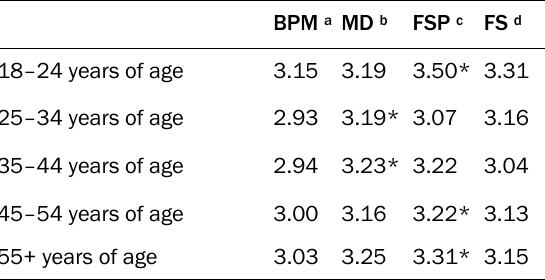
Table 6. Priority Ranking of Survey Categories by Respondents’